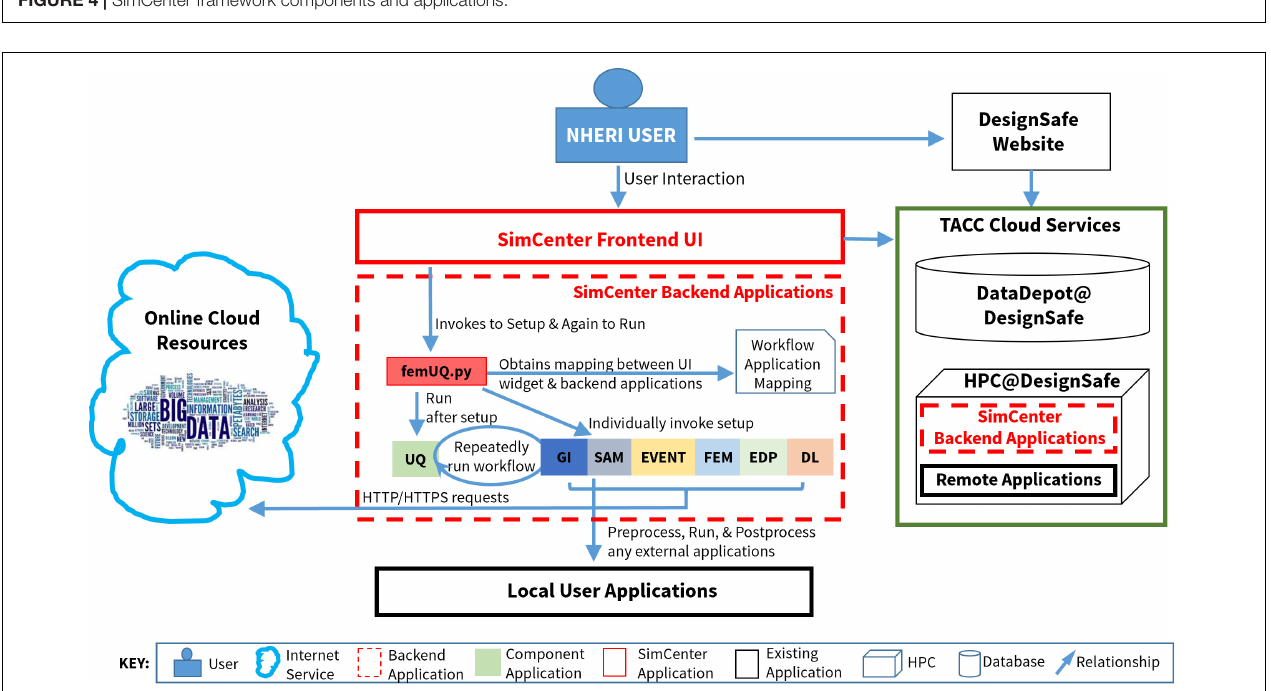
FIGURE 4 | SimCenter framework components and applications.